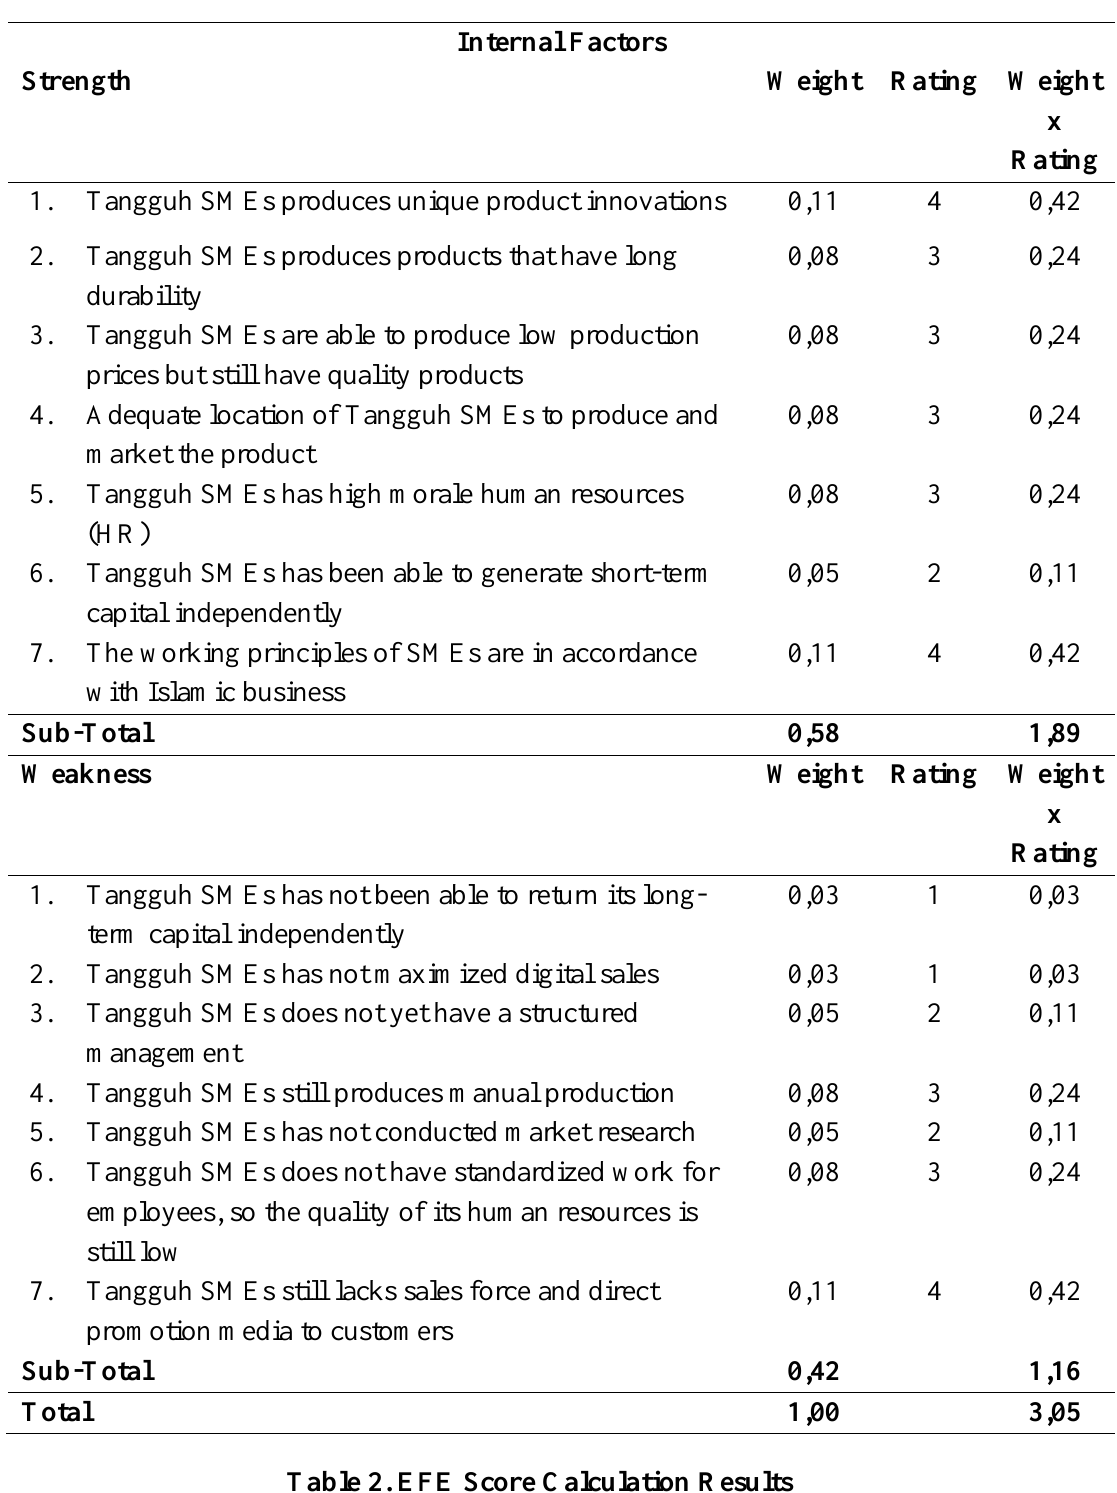
Table 1. IFE Score Calculation Results